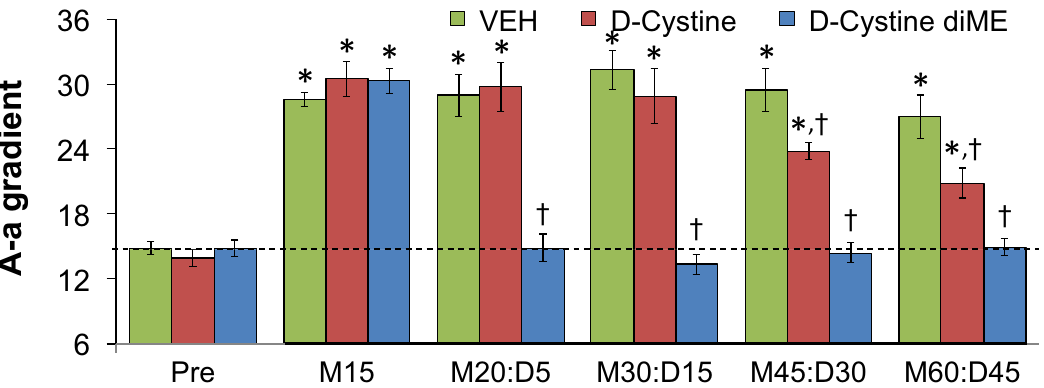
Figure 6. Changes in A-a gradient elicited by an injection of morphine (10 mg/kg, IV) in 3 separate groups of freely moving rats followed by injection of vehicle (VEH, saline), d-Cystine (500 μmol/kg, IV) or d-cystine dimethyl ester (d-cystine diME, 500 μmol/kg, IV). M15–M60, 15–60 min after injection of morphine. D5–D45, 5–45 min after injection of drug (vehicle, d-Cystine or d-cystine diME). The data are shown as mean ± SEM. There were 9 rats in each group. *P < 0.05, significant change from Pre-values. † P < 0.05, d-cystine diEE versus vehicle.